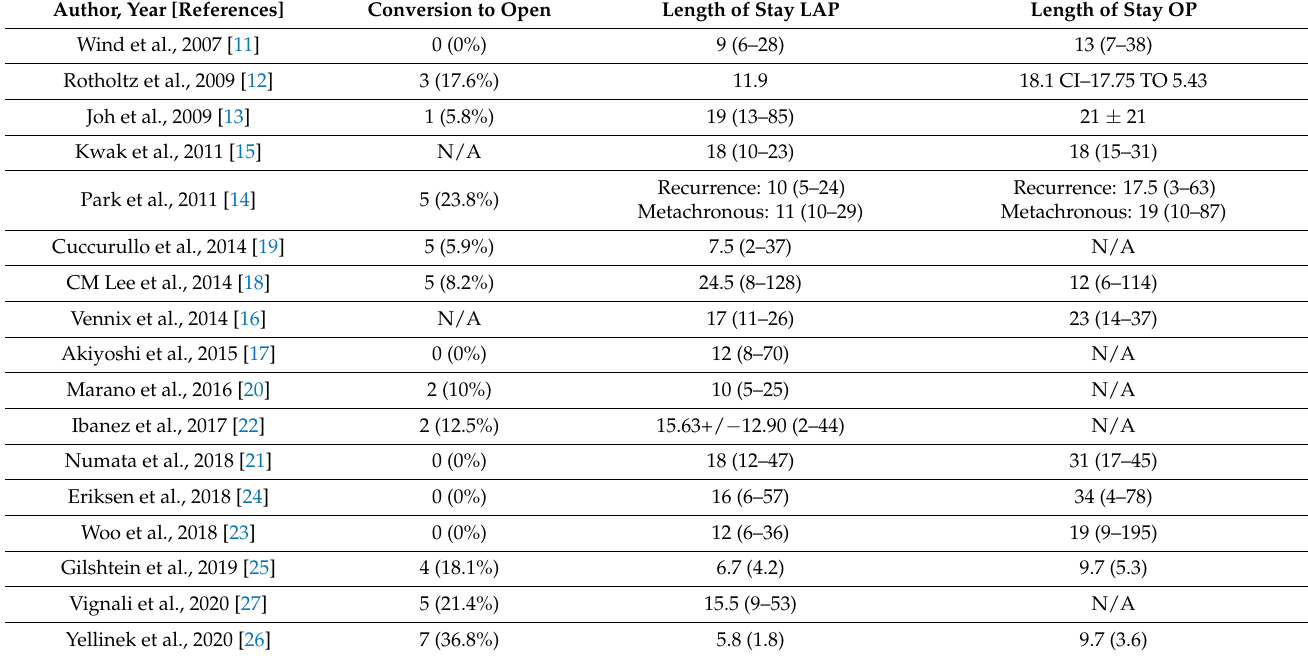
Table 3. Secondary